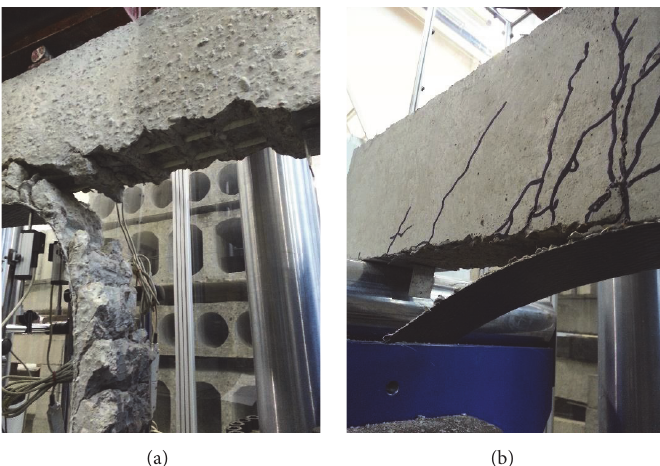
Figure 11: Failure character of RC beams: concrete rip-off of the beam ( B1-nm-C1-F0 ) made of ordinary concrete (a); CFRP peeling-off of the beam ( B6-C1-F0.8 ) made of SFRC (b).